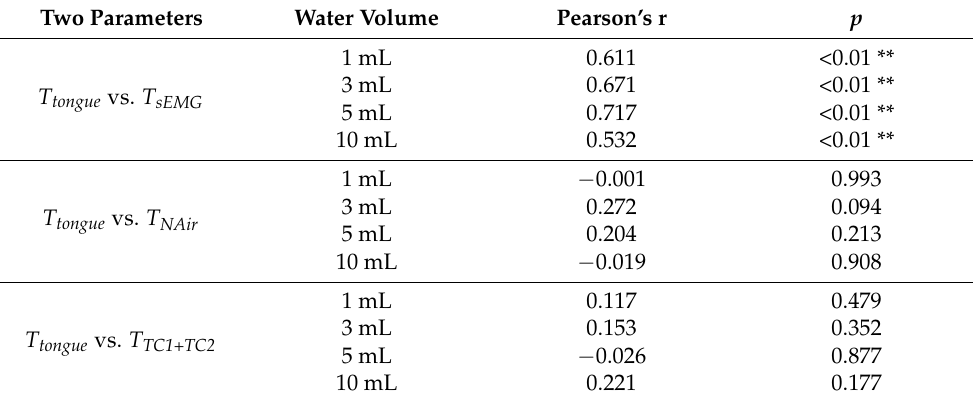
Table 12. Correlations between tongue pressure and the other sensors.